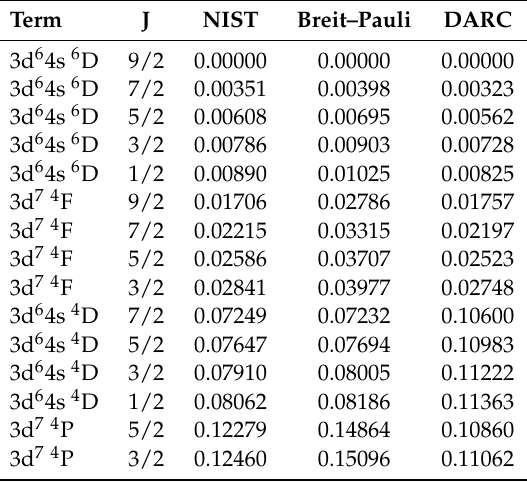
Table 1. Sample of fine structure energies (in Rydbergs) of the first 15 levels of Fe II from the present Breit–Pauli and DARC calculations compared to experimental energies given in the NIST